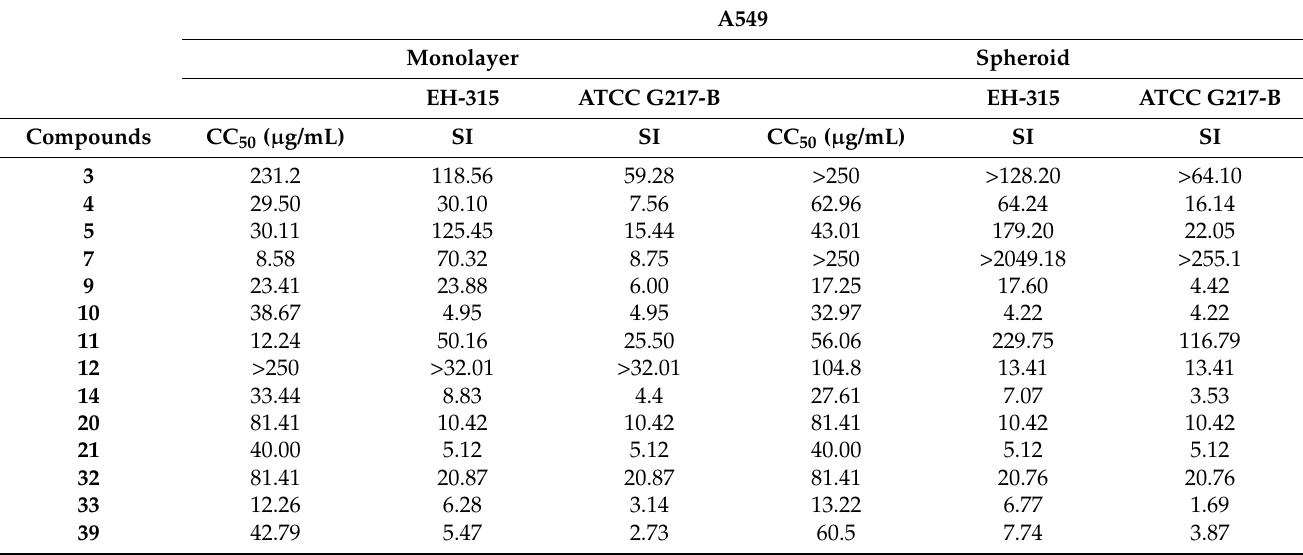
Table 4. Values of CC 50 ( µ g/mL) and SI for the A549 cell line in the monolayer and the 3D model treated with nitrofuran and indole derivatives.